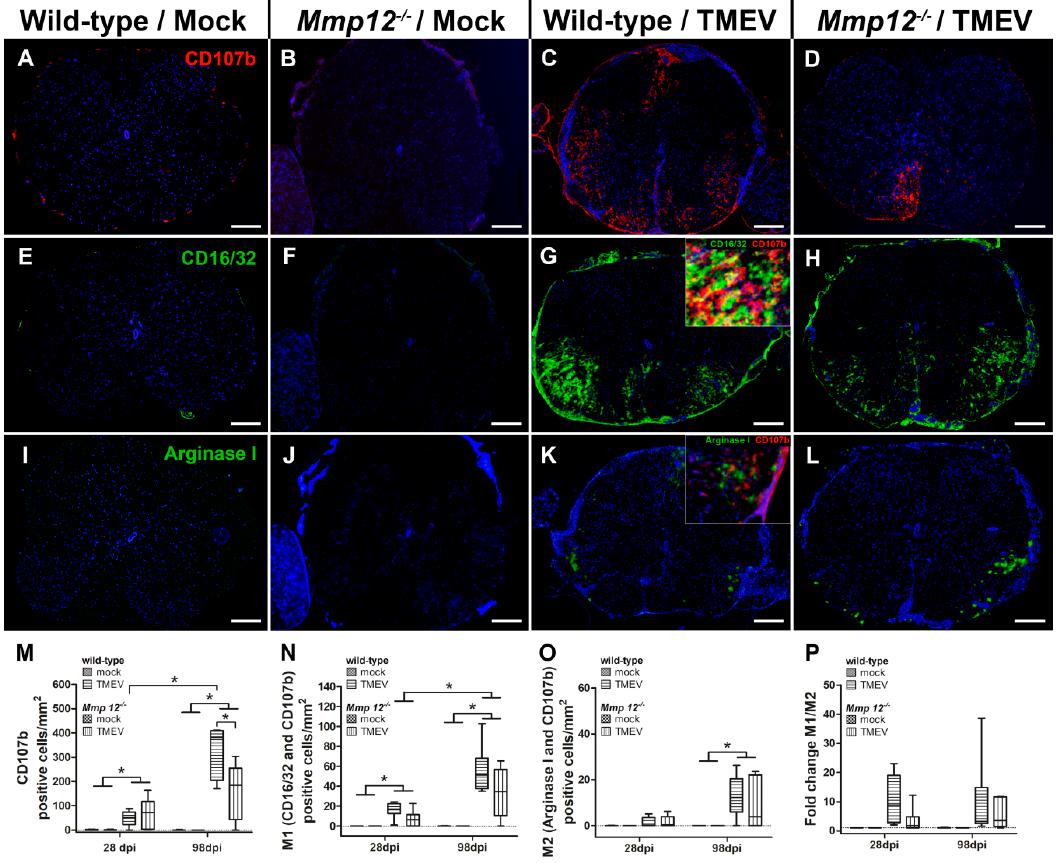
Figure 4. Immunophenotyping of microglia/macrophages in cervical and thoracic spinal cord using immunofluorescence. The density of microglia/macrophages was quantified using CD107b immunofluorescence ( A – D ). Mock-infected wild-type ( A ) and Mmp12 − / − ( B ) mice showed only single immunopositive cells compared with TMEV-infected wild-type ( C ) and Mmp12 − / − ( D ) mice at 98 dpi. Wild-type mice showed a significantly increased density of CD107b-positive cells at 98 dpi compared with 28 dpi ( M ). In addition, the density of CD107b-positive cells in TMEV-infected Mmp12 − / − mice was significantly reduced at day 98 compared with TMEV-infected wild-type mice ( M ). M1 cells were identified by immunofluorescence targeting CD16/32 in combination with CD107b ( E – H ). Mock-infected wild-type ( E ) and Mmp12 − / − ( F ) mice showed few M1 cells compared with TMEV-infected wild-type ( G ) and Mmp12 − / − ( H ) mice at 98 dpi. The insert ( G ) shows colocalization (yellow color) of CD16/32 (marked in green) and CD107b (marked in red). The density of M1 cells in TMEV-infected mice increased over time ( N ). At 28 dpi, a trend ( p = 0.073) for a reduced density of M1 cells in TMEV-infected Mmp12 − / − compared with TMEV-infected wild-type mice was detected ( N ). M2 cells were identified by immunofluorescence targeting arginase I in combination with CD107b ( I – L ). Mock-infected wild-type ( I ) and Mmp12 − / − ( J ) mice showed low numbers of M2 cells compared with TMEV-infected wild-type ( K ) and TMEV-infected Mmp12 − / − ( L ) mice at 98 dpi. The density of M2 cells was increased in TMEV-infected mice at 98 dpi ( O ). The insert ( K ) shows colocalization (yellow color) of arginase I (marked in green) and CD107b (marked in red). Bars represent 250 µm in the overview pictures and 25 µm in the inserts. Fold change analysis revealed a trend ( p = 0.073) for M1 dominance in TMEV-infected wild-type mice compared with TMEV-infected Mmp12 − / − mice at 28 dpi ( P ). Data are shown as box plots with whiskers indicating minimum and maximum values—the lower boundary of the boxes representing the 25th percentile, the upper boundary the 75th; the horizontal line in the boxes represents the median value ( M – O ). Significant differences between the groups as detected by Mann–Whitney U test are marked by bars and asterisks (* p <